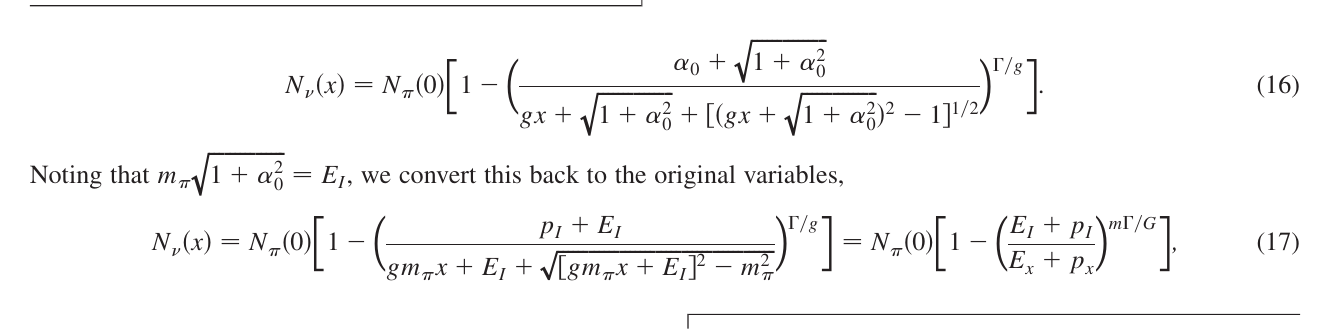
ffiffiffiffiffiffiffiffiffiffiffiffiffiffiffi